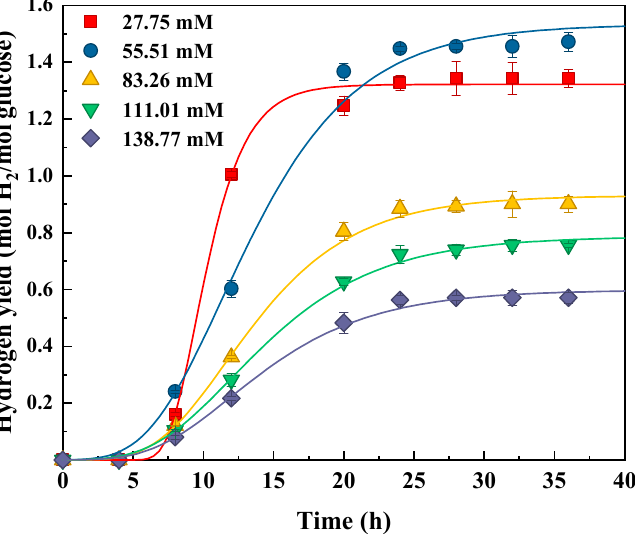
Figure 1. Cumulative bio-hydrogen yield from glucose at varying concentrations with simulation curves based on the modified Gompertz equation.